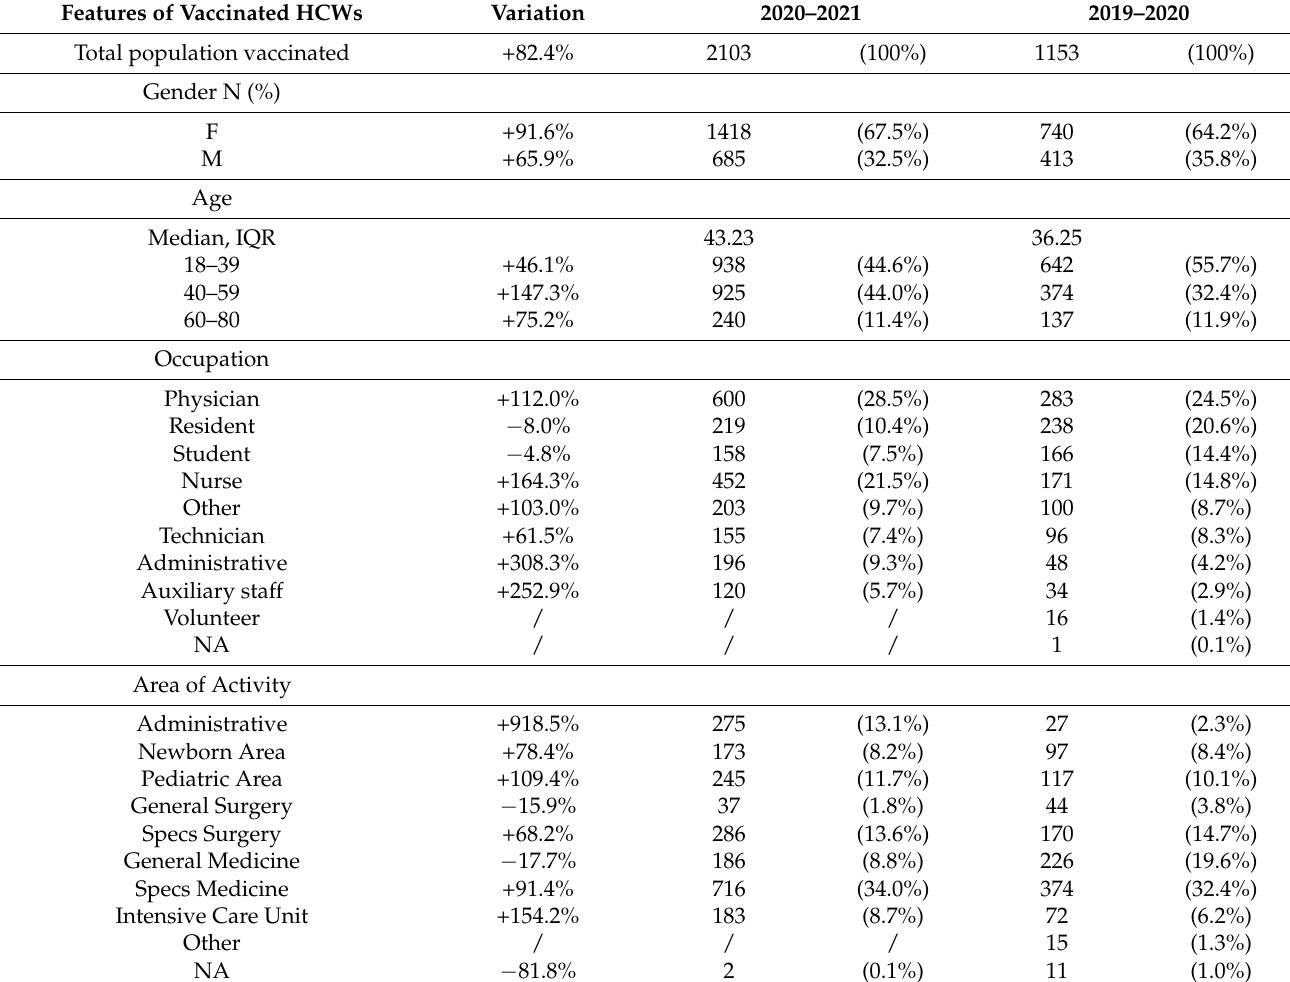
Table 1. Comparison between vaccinated populations, 2020–2021 and 2019–2020 seasons. Features of Vaccinated HCWs